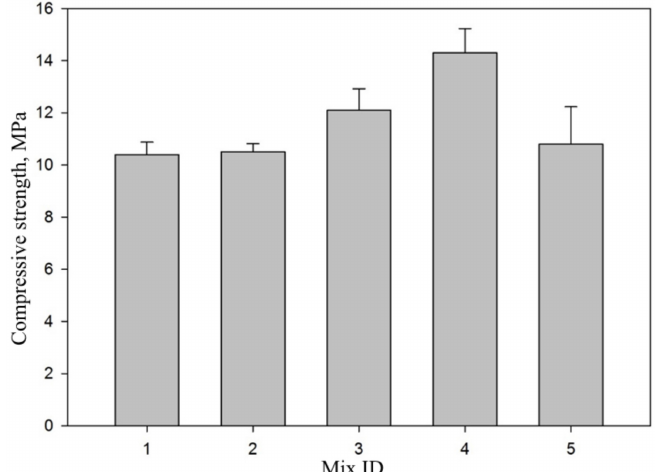
Figure 5. Compressive strength of model samples with the ratio